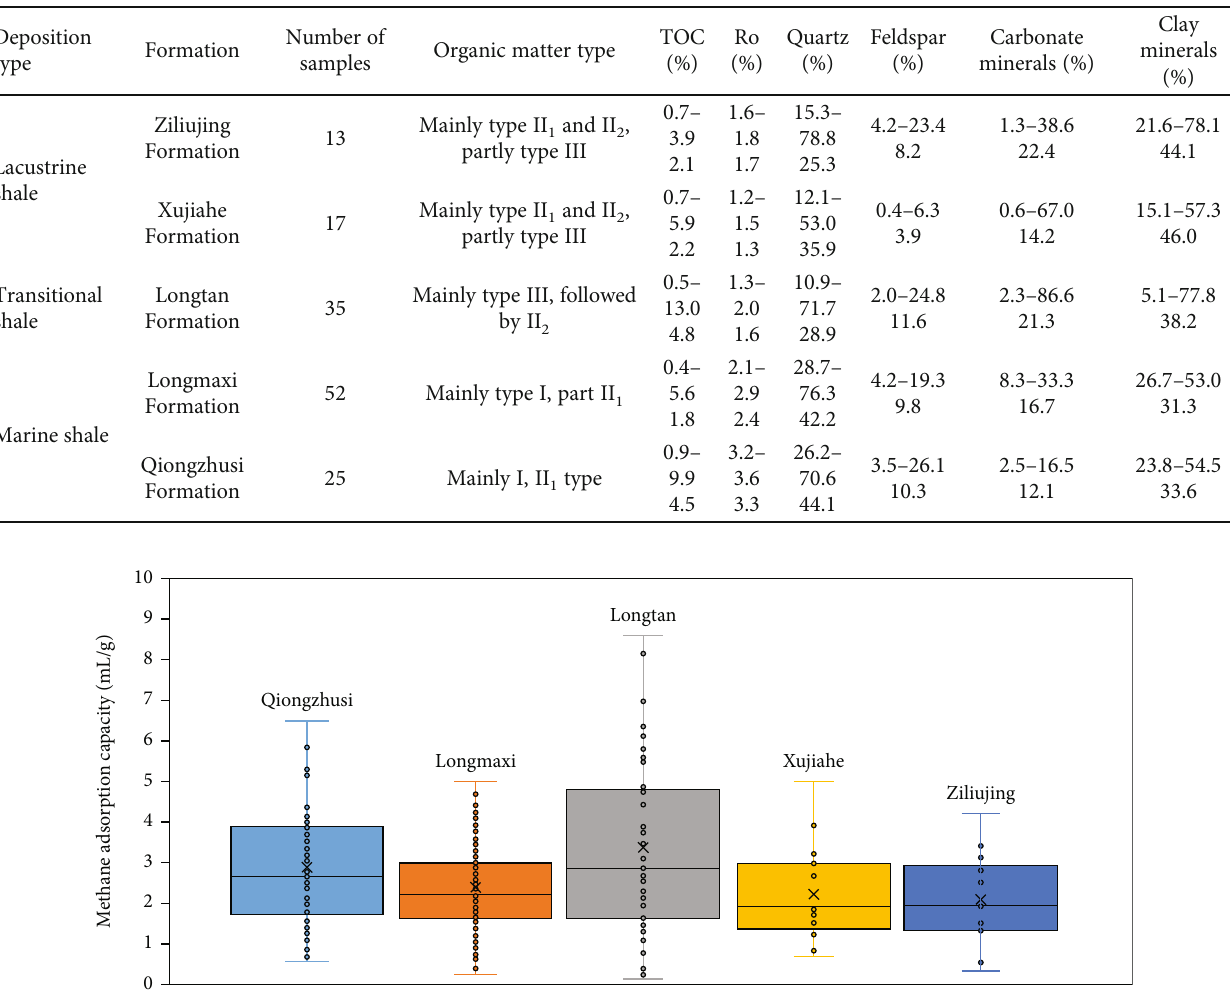
Figure 3: Methane adsorption capacity of di ff erent types of shale. All 5 sets of shales have high methane adsorption capacity, among which the Longtan Formation Shale has the strongest methane adsorption capacity, followed by the Qiongzhusi Formation and the Longmaxi